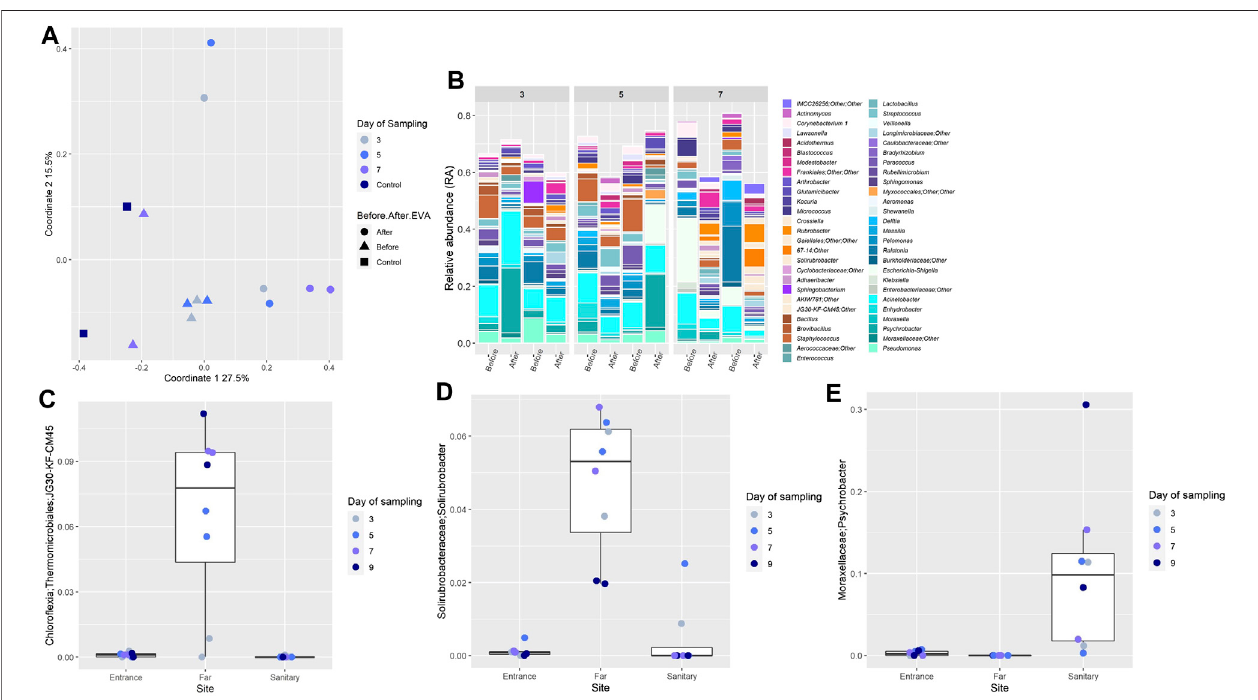
FIGURE 4 | (A) Similarity in microbial composition on nitrile gloves before and after EVAs. PCoA of all glove samples throughout the mission, visualizing the spatial relationships between samples. (B) Relative abundance of bacterial OTUs comprising samples of gloves samples. Each sample is paired, e.g. before and after an EVA. Each color on the graph represents a distinct family level OTU. Only taxa that constituted RA of > 1% in individual samples are presented, unless stated otherwise. Bar plots were generated using R. (C – E) Relative abundance of selected bacterial OTUs shared between soil and nitrile gloves samples. In the boxplots, lines indicate median relative abundances, boxes denote third and fi rst quantile, whiskers denote ± 1.5 * IQR, and outliers are shown as